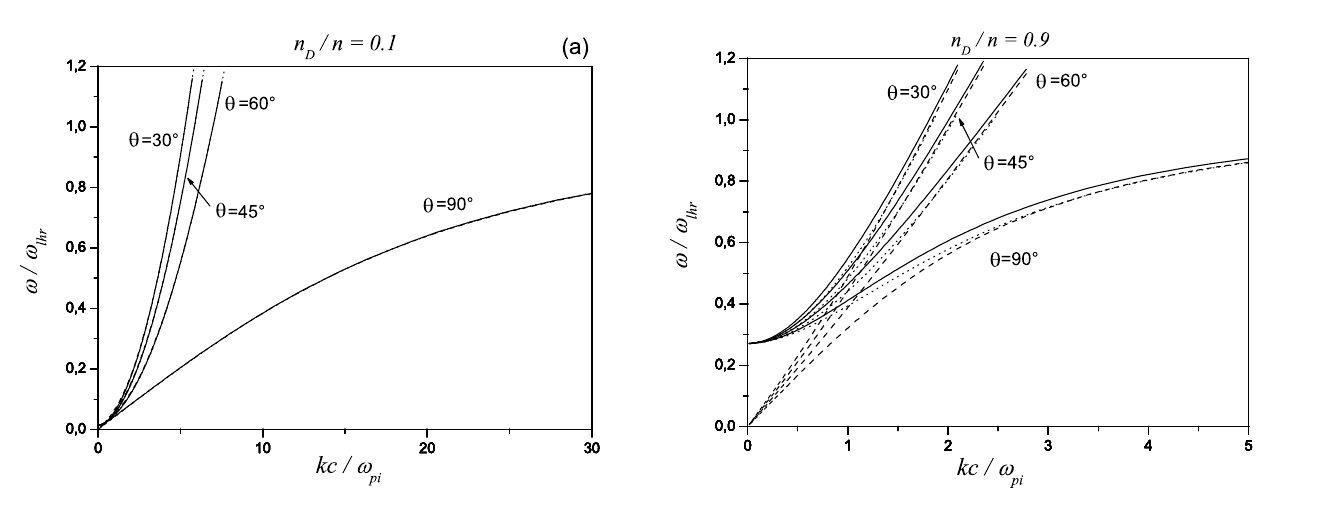
Fig. 1a. Dispersion laws ( ω/ω lhr as a function of kc/ω pi ) for dif- ferent wave vector orientations with respect to the magnetic field ( θ = 30, 45, 60, and 90 degrees) in a plasma with two positive ions H + , O + , at an altitude h ’ 1900km, and with a negative O − relative content of n D /n = 0 . 1. Solid lines: new dispersion law; dotted lines: whistler solution of the total cold plasma dispersion law; dashed lines: modified whistler dispersion law ω md . Main parameters are: